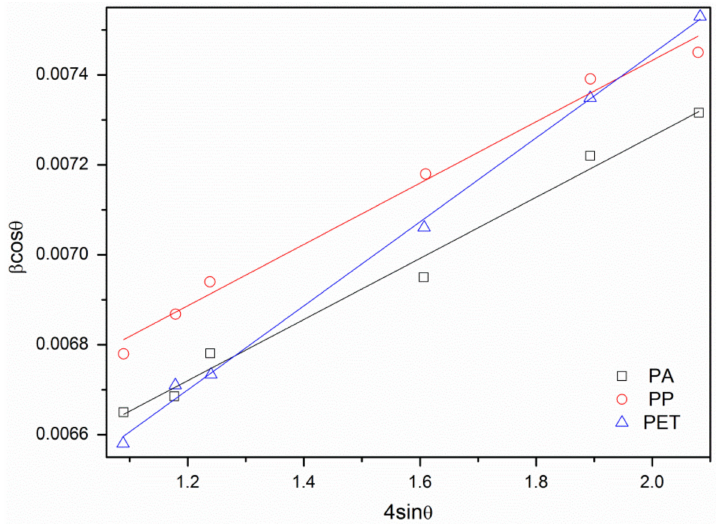
Figure 6. The W-H curves for